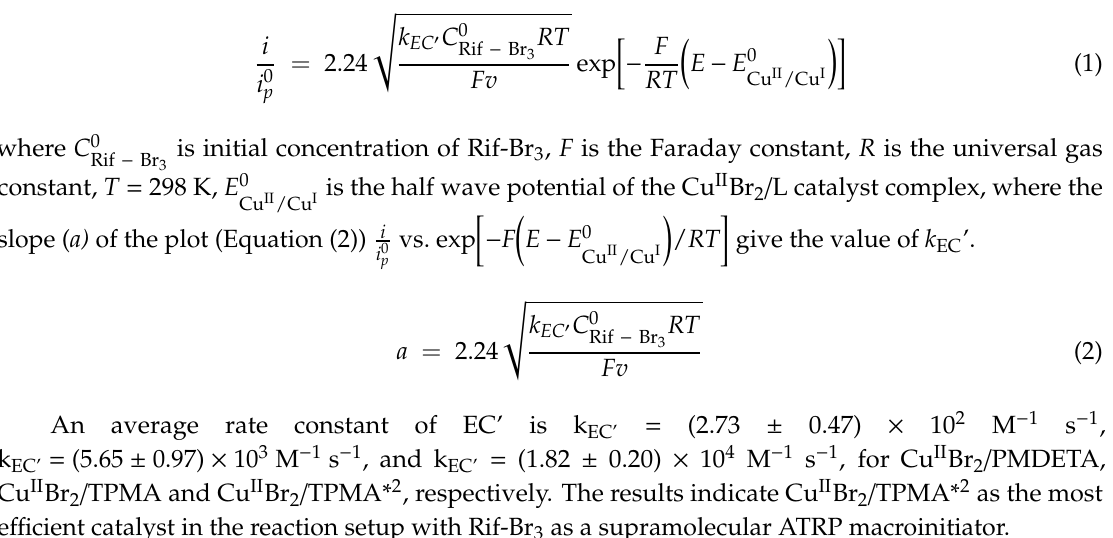
e ffi cient catalyst in the reaction setup with Rif-Br 3 as a supramolecular ATRP